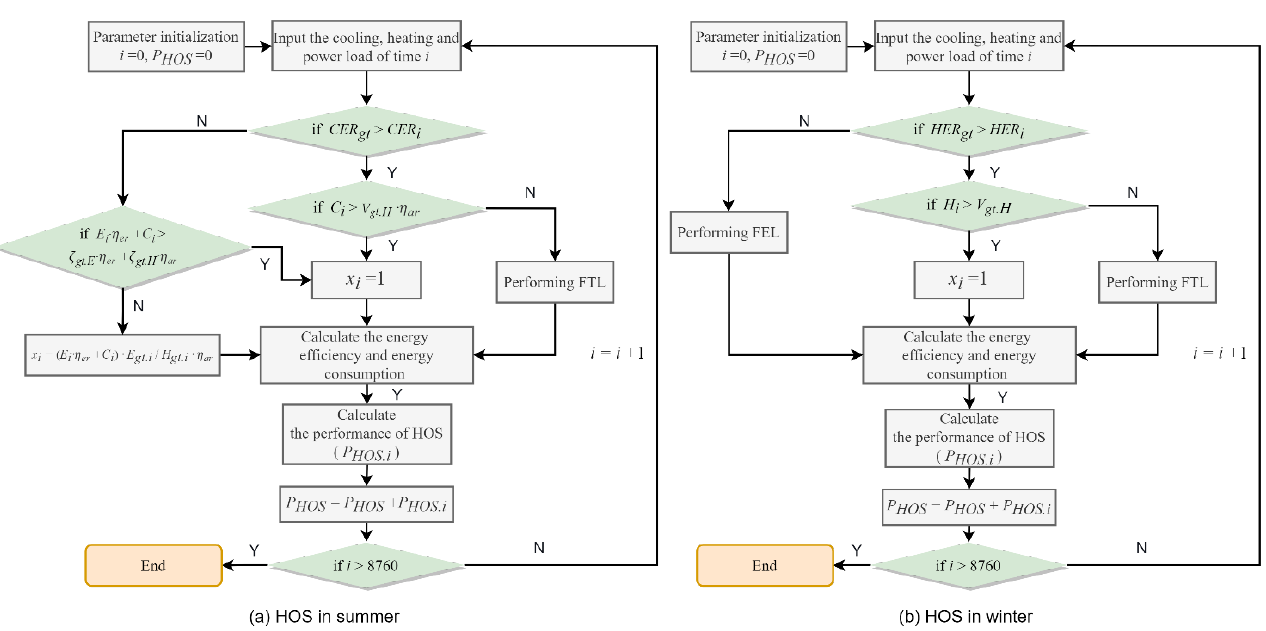
Figure 6. Flowchart of HOS operational strategy in the summer ( a ) and winter ( b ).